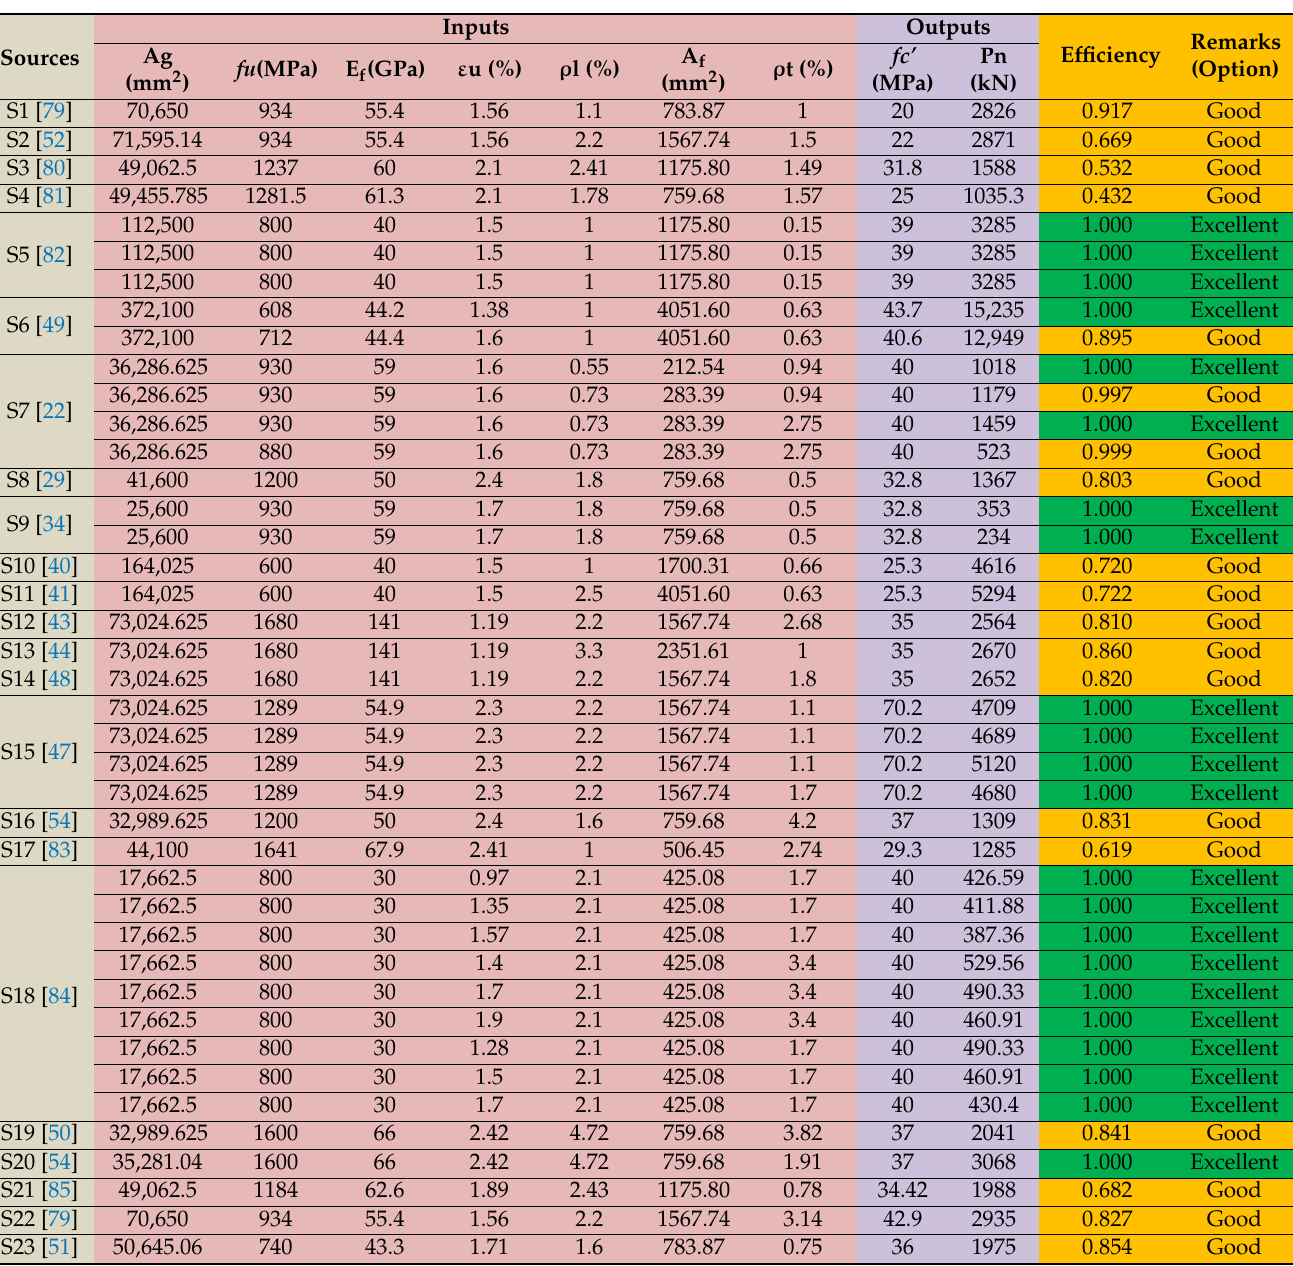
Table 2. DEA-based efficient combination evaluation of GFRP-based